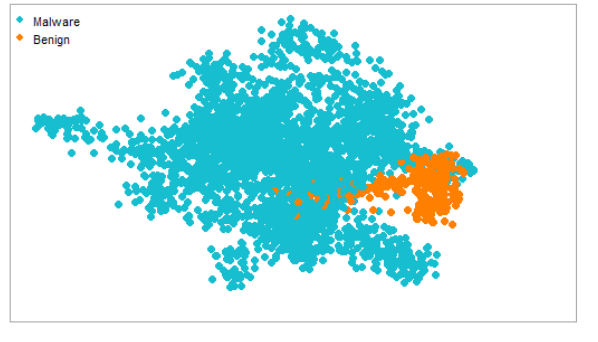
( d ) Figure 12. t-SNE visualization for fused features using minimum (30 and 35) and optimal (50 and 70) perplexity values. ( a ) Perplexity, 30; ( b ) perplexity, 50; ( c ) perplexity, 35; ( d ) perplexity, 70. 5. Conclusions Mobile apps are susceptible to malicious network activity because of their frequent remote access. Such threats could gather crucial information while adversely affecting commerce, social order, and financial institutions. The malware detection system used in this study takes advantage of the combined influence of textual and textural features, com- bining the strengths of text and visual elements. We proposed an algorithm for a packet